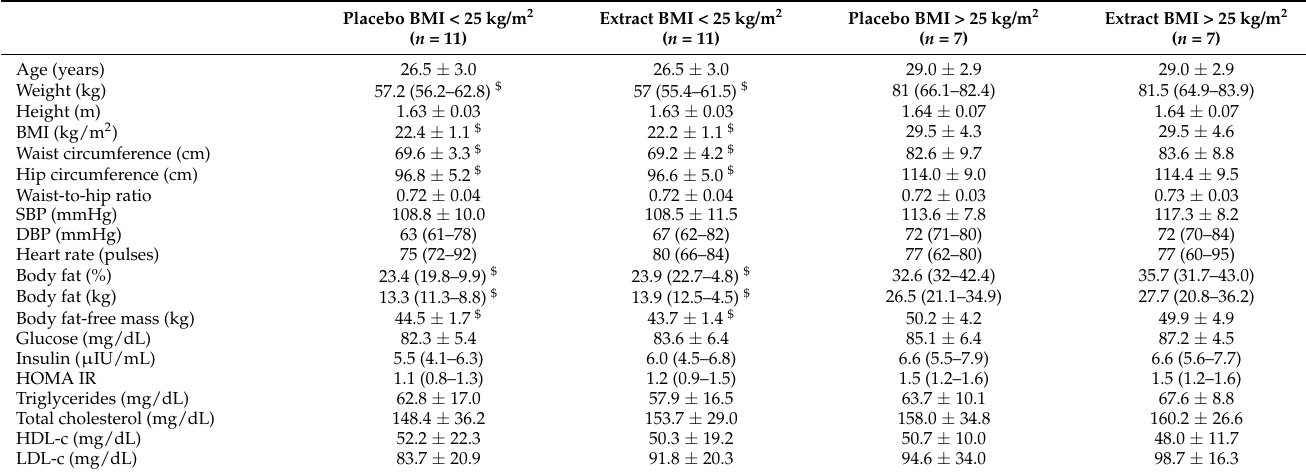
Table 1. Anthropometric features and basic biochemical markers in the two interventions at baseline with respect to BMI categories.